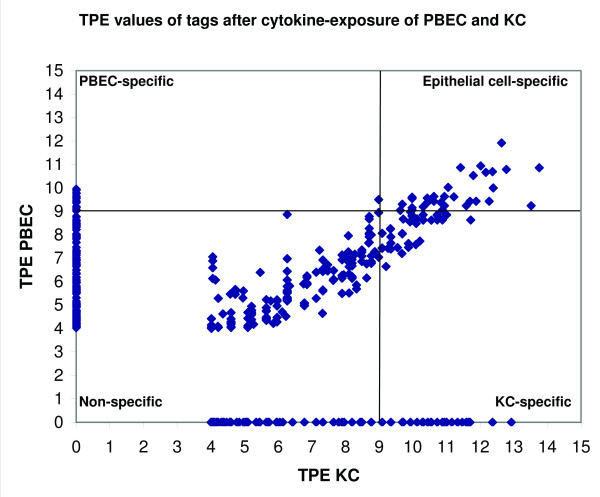
TPE scatter plot of SAGE tags of PBEC and KC libraries after cytokine exposure. Reliable 3'-end tags with TPE>4 and tag frequency of = 2 in at least one library were plotted. Tags with corresponding TPE values = 9 in both libraries were considered to be potential epithelial cell-specific tags as indicated by the threshold lines in the figure. A similar picture was obtained when TPE values of tags from the resting libraries were plotted.